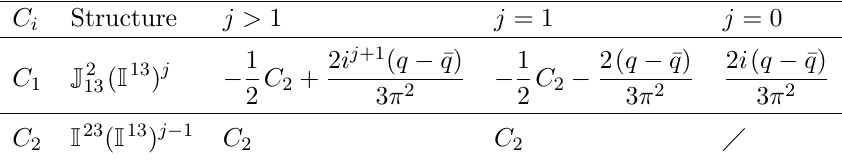
OJO when O has spin ( 1 h i